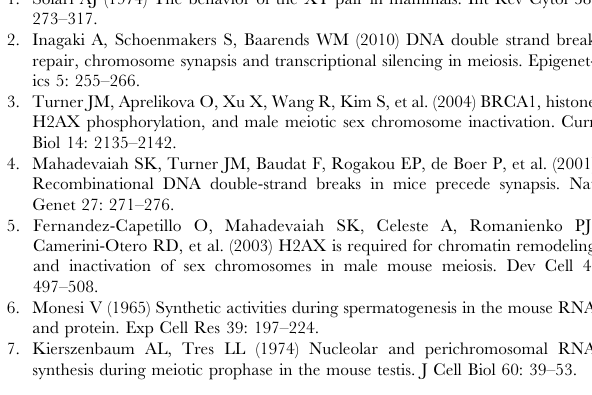
Figure S2 Validation of RNA FISH signals at different denaturation temperatures. B–H The dotted circle indicates the XY body. A Lymphocyte metaphase. After DNA FISH the Cot-1 probe hybridizes to all chromosomes and showed more intense staining at the centromeric heterochromatin. B Pachytene spermatocyte nucleus. After DNA FISH the Cot-1 probe hybridized to all autosomal chromosomes and showed decreased hybridization signal for X,Y chromatin. C RNAse-treated pachytene spermatocyte nucleus. After DNA FISH the Cot-1 probe hybridized to all chromosomes with more intense staining at the centromeric heterochromatin. D Pachytene spermatocyte nucleus. After RNA FISH at 72 u C the Cot-1 probe hybridized to all autosomal chromosomes and showed decreased hybridization signals for XY chromatin. E RNAse treated pachytene spermato- cyte nucleus. After DNA FISH at 62 u C the Cot-1 probe was not RNA FISH at 62 u C, 52 u C and 37 u C respectively, the Cot-1 probe hybridized to all autosomal chromosomes and showed decreased hybridization signals for the XY chromatin. Figure S3 Graphical representation of histone dynam- ics at the XY chromatin in late pachytene spermato- cytes. A–E Late pachytene nuclei were assigned to four groups, ranging from a low to a high degree of nucleosome eviction (see Figure 1B) (for probands included and number of nuclei see Table 2). Histone characteristics and histone N-tail modifications were subjectively determined for the XY body and in A for autosomal chromatin as well: A Nuclei were categorized into three goups (bars). ‘Low staining, higher at XY’ indicates at the observation of low, even autosomal staining with more intense staining at the XY body. ‘General low staining’ indicates at an